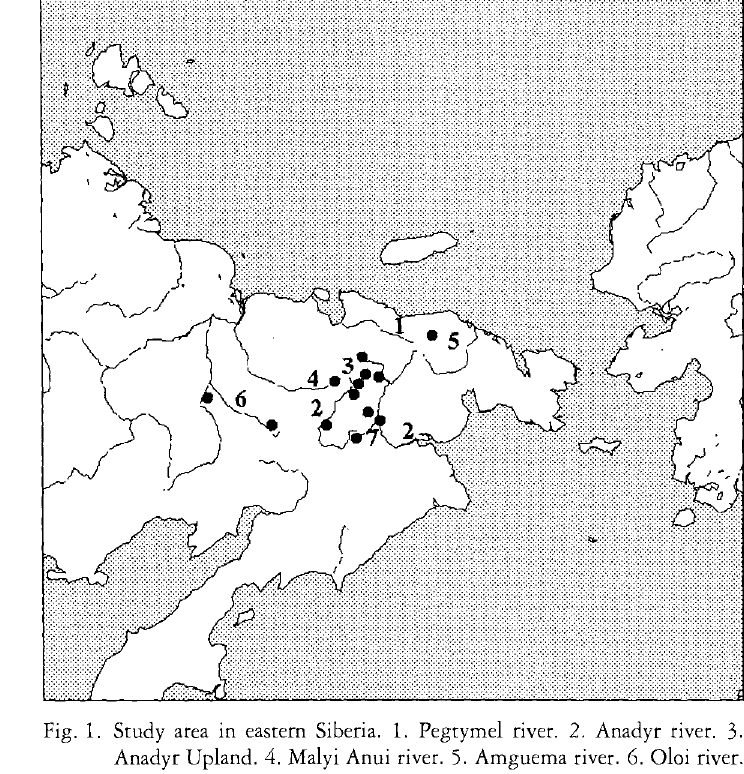
Fig. 1. Study area in eastern Siberia. 1. Pegtymel river. Anadyr Upland. 4. Malyi Anui river. 5.